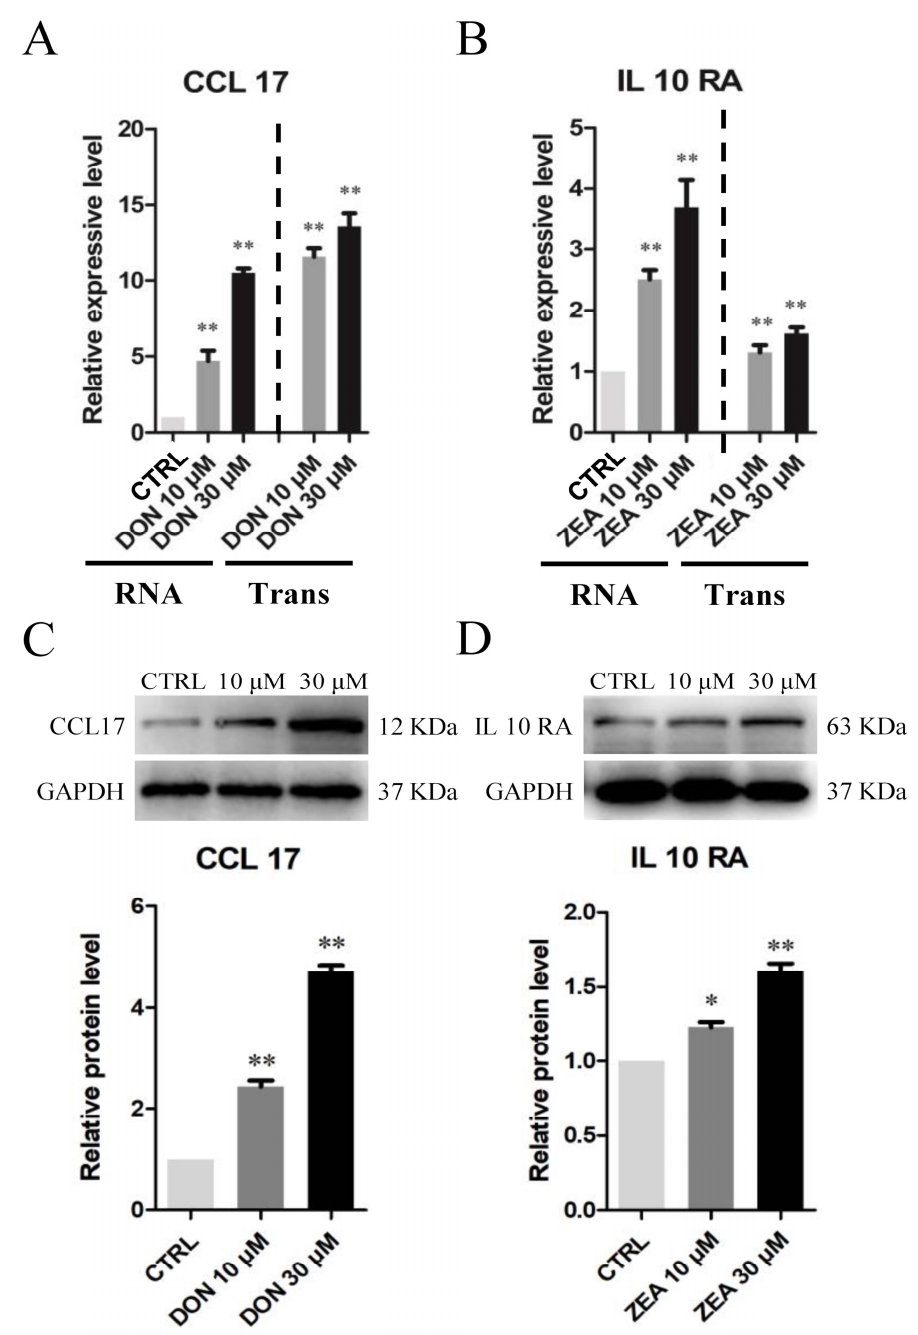
Figure 9. DON and ZEA exposure affects the mRNA and protein abundance levels of inflammation-related genes in cultured Equus asinus SCs. ( A ) Quantitative RT-PCR for the CCL17 transcription factors. ( B ) Quantitative RT-PCR for the IL10RA transcription factors. The mRNA levels of the gene were normalised to the GAPDH gene. ( C ) Protein levels of CCL17 / GAPDH by Western blot. ( D ) Protein levels of IL10RA / GAPDH by Western blot. The protein levels were normalised to GAPDH . The exposure time was 50 s. The results are presented as the mean ± SD. All experiments were repeated at least three times. * p < 0.05; ** p < 0.01.